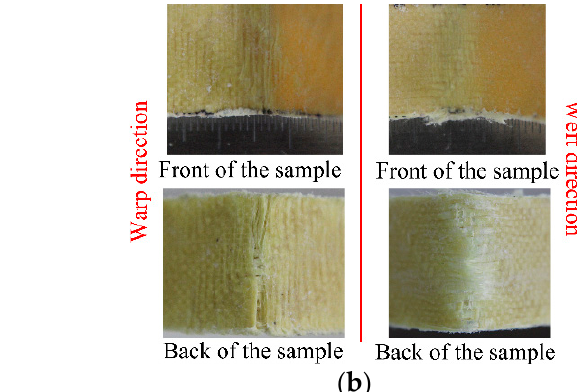
Figure 3. Bending failure morphologies of 3DDAI of Kevlar/EP armor materials with 1 to 2 layers.